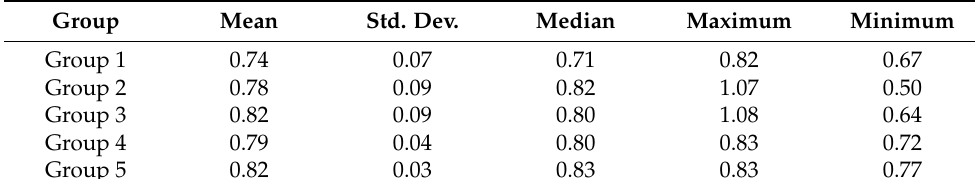
Table 8. Emissions of electrical origin per inhabitant, in tCO 2 /year.